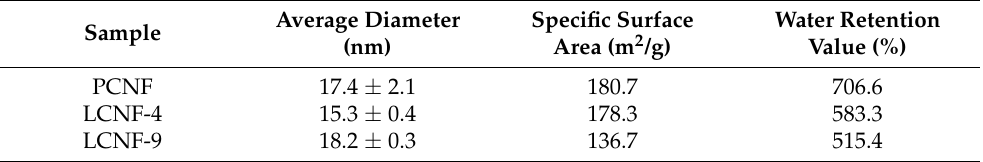
Figure 2. Morphological characteristics of PCNF, LCNF-4, and LCNF-9. Table 2. Average diameter, specific surface area, and water retention value of PCNF, LCNF-4, and LCNF-9.